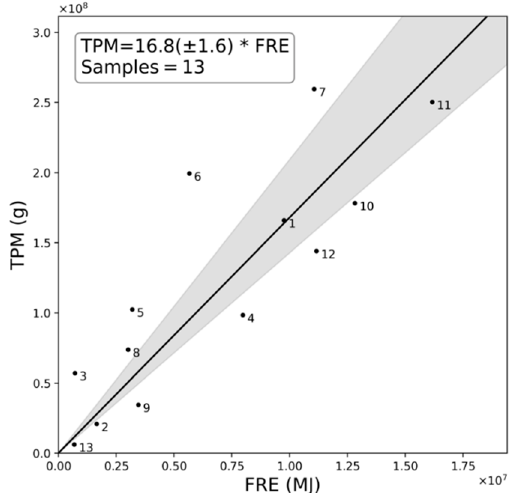
comparison, in Table 2 are the existing TPM 𝐶 (cid:3032) published for SE Asian peatland fires, either derived from the multiplication of an FRE to fuel consumption conversion factor with a TPM emission factor [27], or calculated directly via a “top-down” method relating FRE to TPM emissions [37]. Values range from 69.3 g·MJ − 1 in the former case to 52.4 g·MJ − 1 in the latter, and are far higher than the 16.8 ±